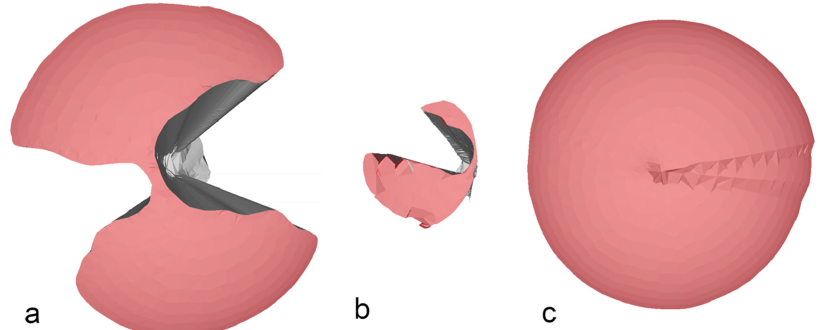
Figure 4. Examples of the area of maneuverability of the SILS-port ( a ), the Endocone ( b ), and the glove port ( c ) when an endoscope and an instrument were inserted in the ports. Note the reduced area of maneuverability caused by instrument interference in the SILS-port and the Endocone, but not in the glove port (images rendered with Blender).